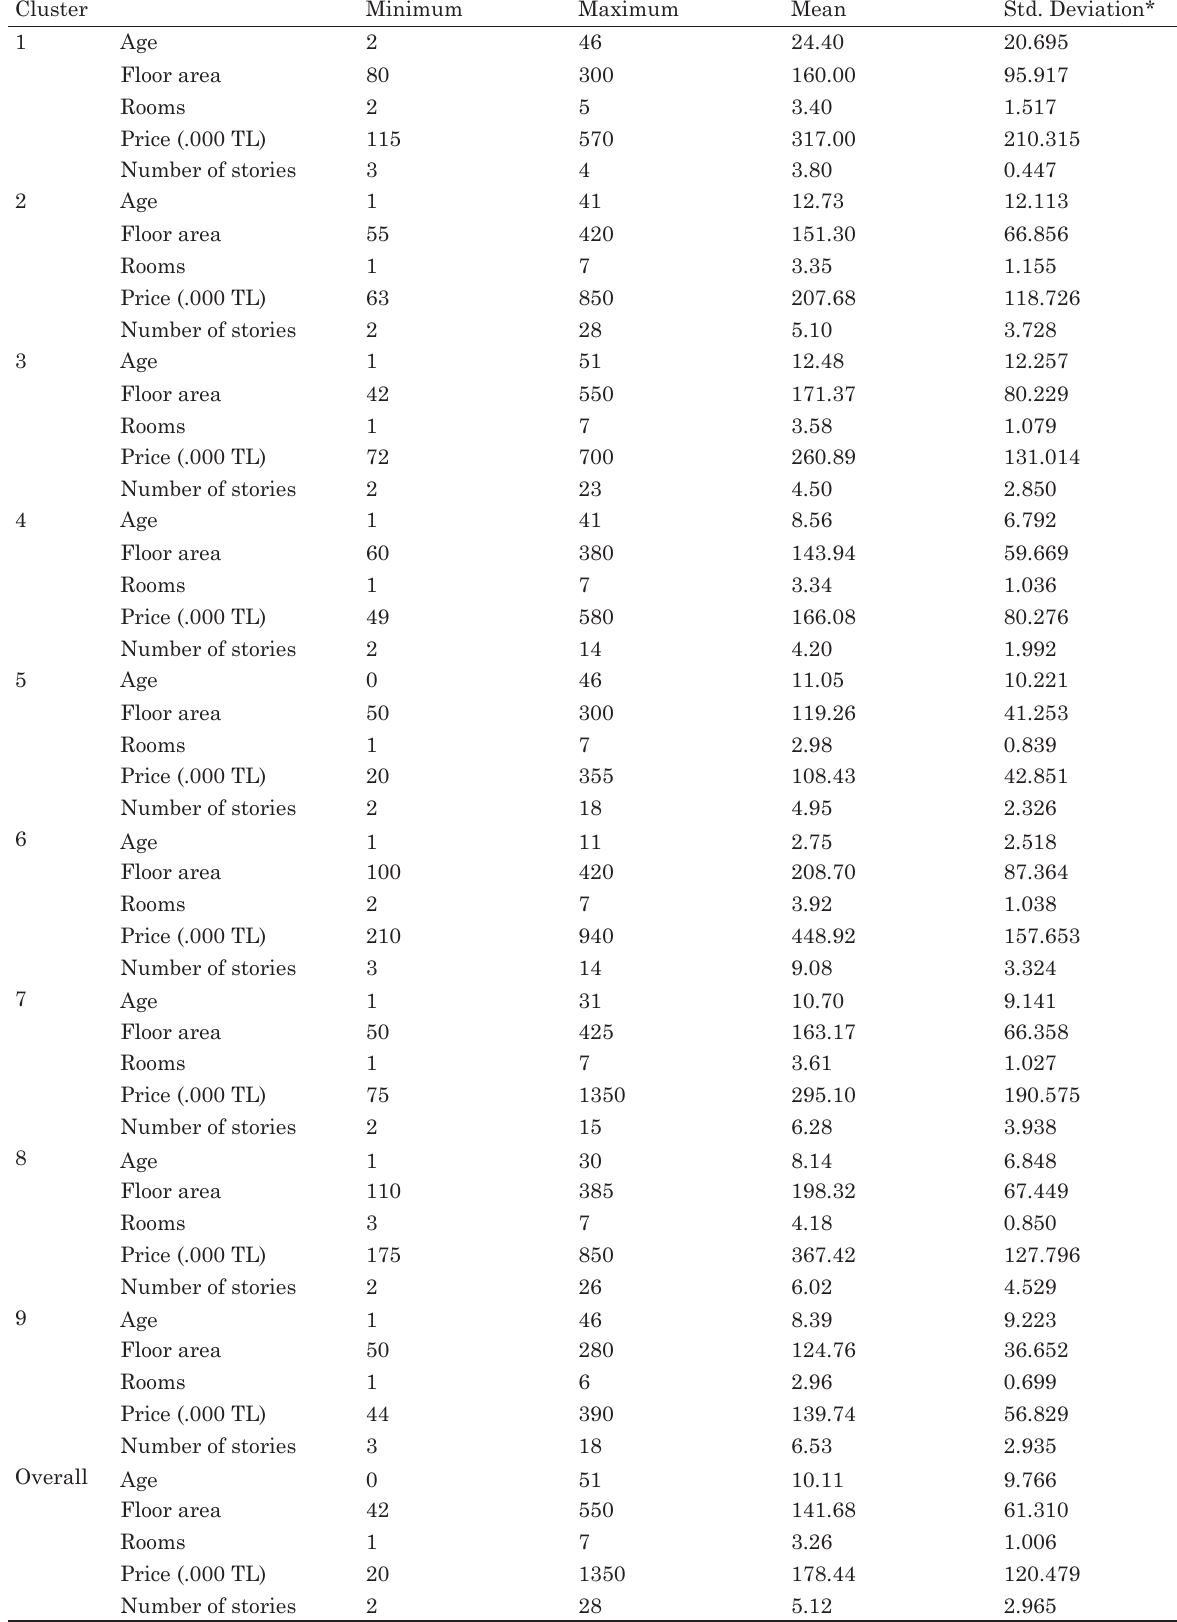
Table 4. Cluster statistics